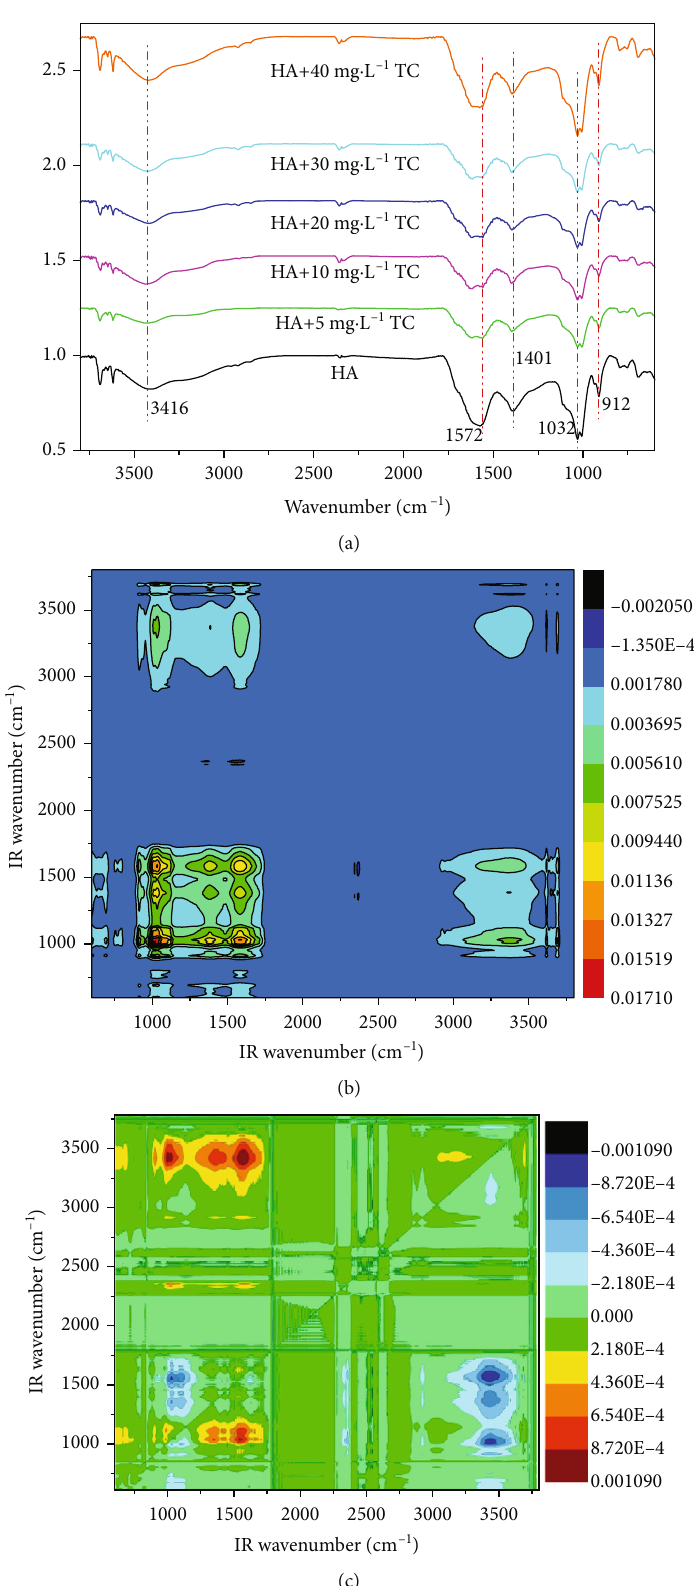
Figure 7: (a) FT-IR spectra of HA sample and HA after adsorbed di ff erent concentrations of TC; (b) synchronous and (c) asynchronous 2D correlation maps generated from the